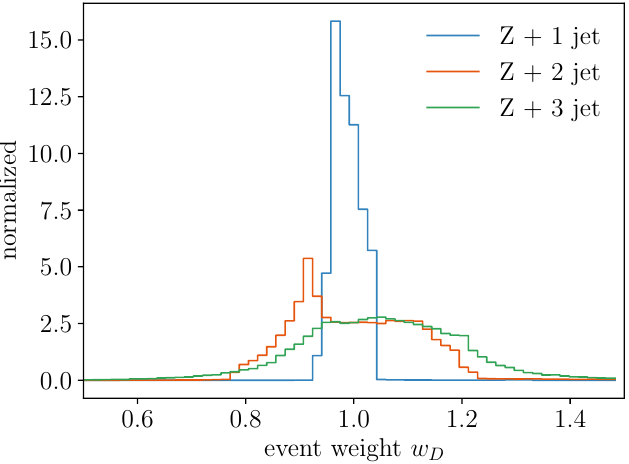
Figure 9: Distribution over the weights w ized phase